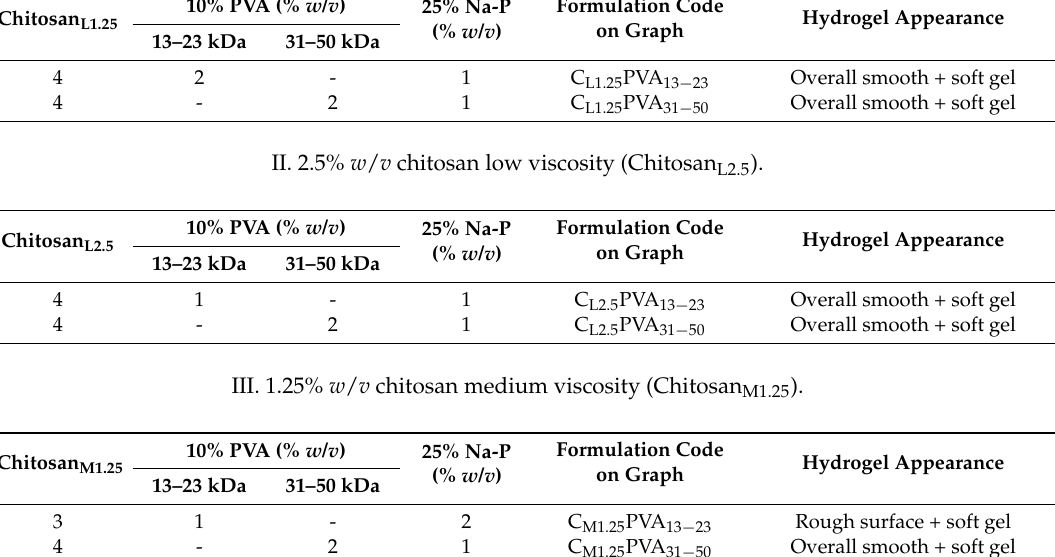
Table 2. Composition of stable hydrogel formulations grouped according to chitosan concentration and viscosity.